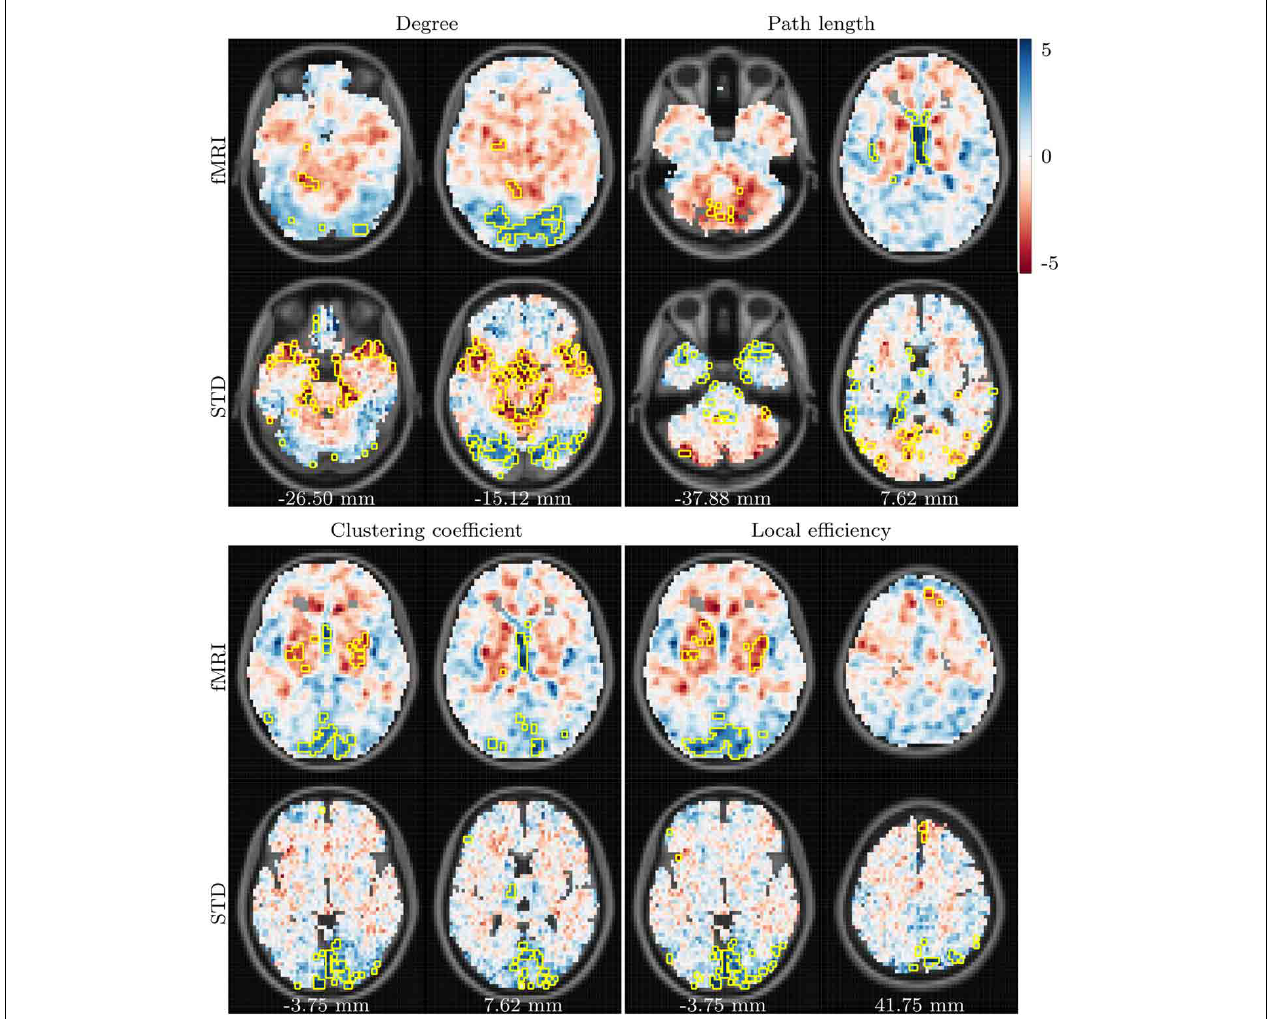
FIGURE 3 | t -values showing differences between the young and aged groups in fMRI and standard space resting state networks. Data for all network measures are shown for correlation threshold